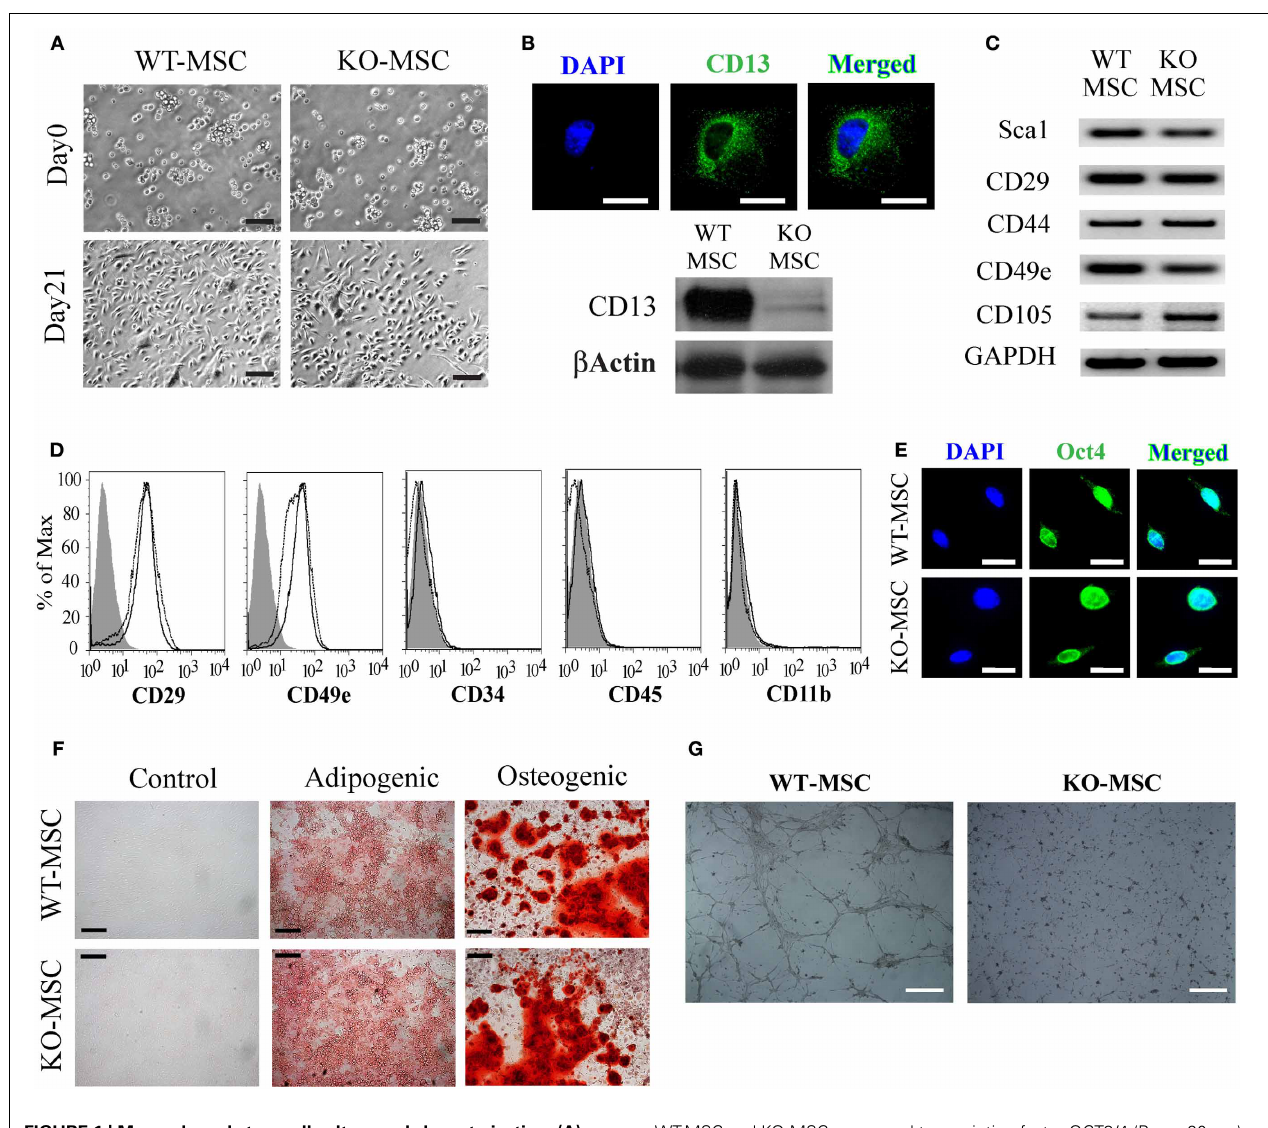
FIGURE 1 | Mesenchymal stem cell culture and characterization. (A) Phase contrast image of BM derived MSCs at Day 0 and Day 21(Bar = 100 μ m). (B) CD13 expression in WT-MSCs by fluorescence immunostaining (Bar = 20 μ m) and protein expression of CD13 in WT-MSC. (C) RT